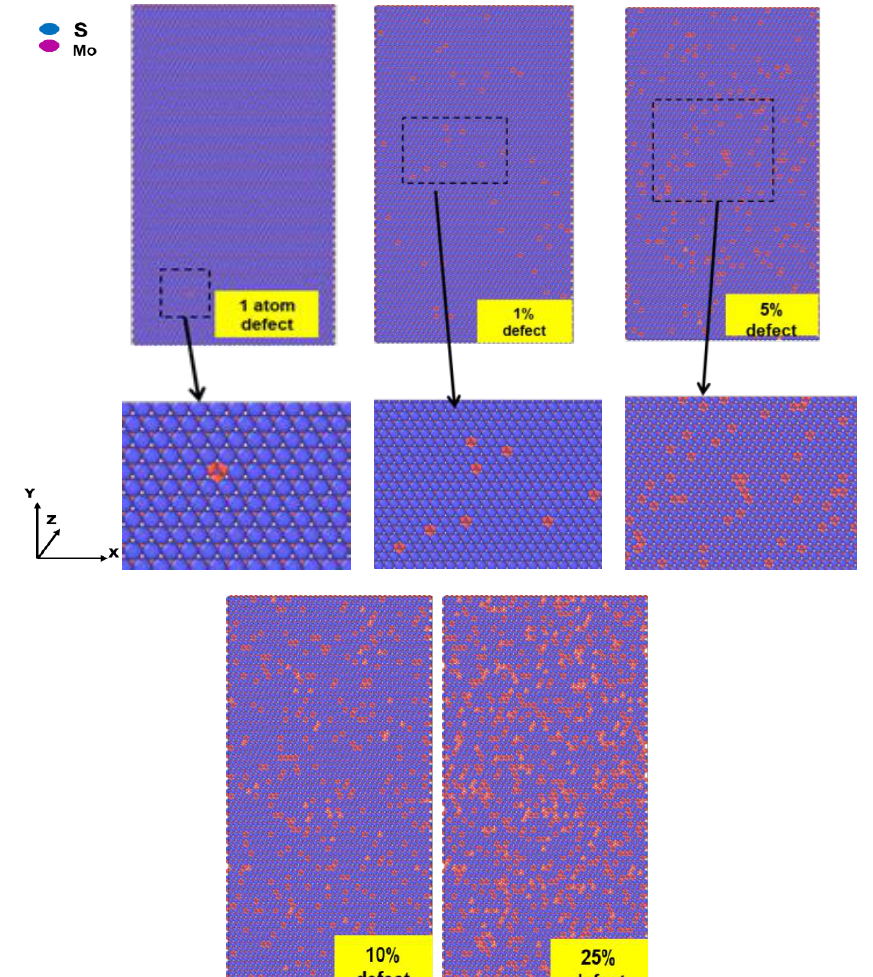
Figure 3. The atomistic model of monolayer MoS 2 with different percentge of defects.